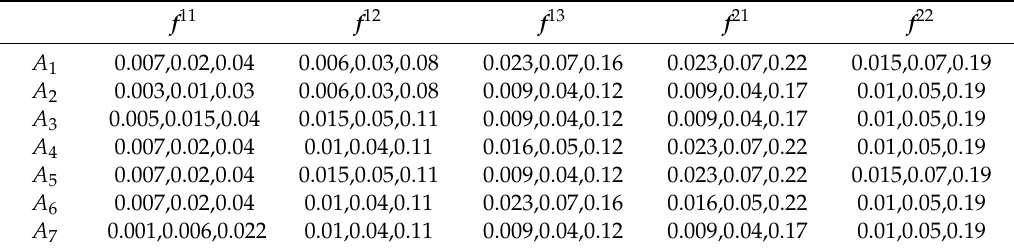
Table 9. Weighted normalized matrix for factor 1 and 2